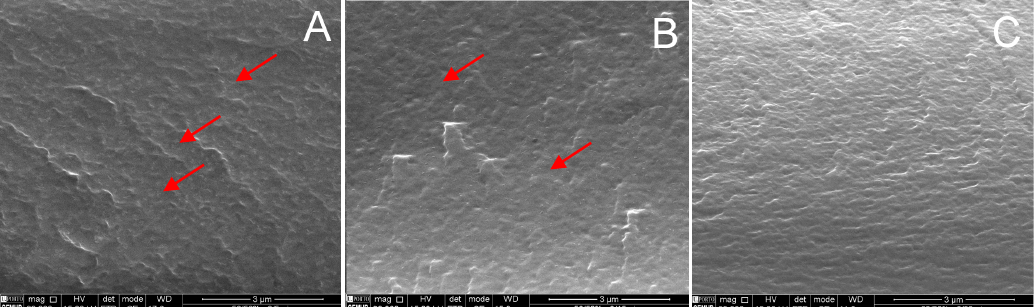
Figure 3. Representative scanning electron microscope images of the cross-sections of cryo-fractured NS/S blend films at a 1:1 ratio, 30,000× magnification. Panel A —NS/S 5 min , Panel B —NS/S 15 min , and Panel C —NS/S 30 min . Red arrows indicate nanosized chitosan molecules.